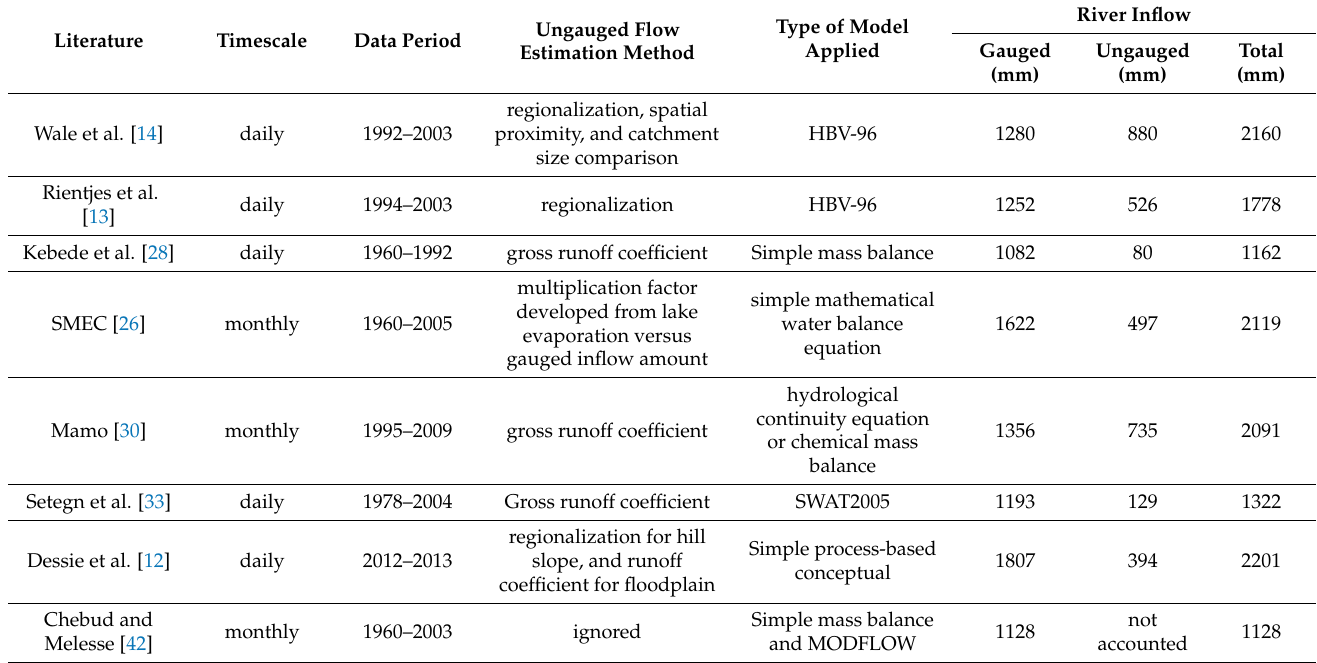
Table 3. Summarized annual estimations for river water inflows of Lake Tana by various authors. The model or estimation technique used, time scale, data period, the gauged areal coverage where the inflow data for model calibration and validation used are